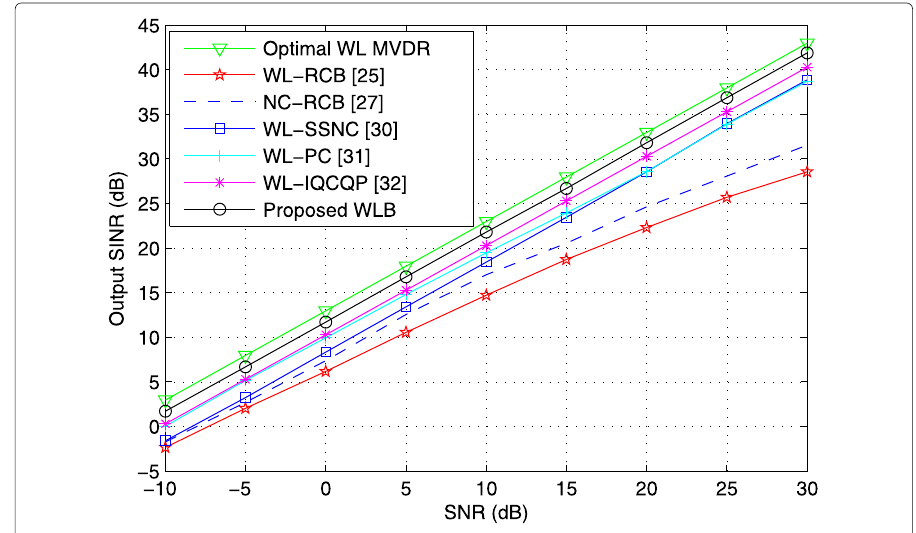
Fig. 2 Example 1. Output SINR of all WLBs versus the input SNR